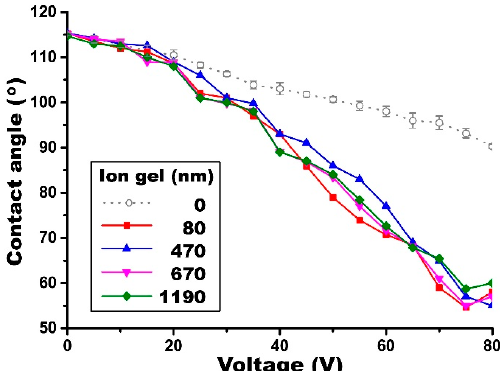
Figure 8. Thickness effect of the dip-coated gel layer on static EWOD performance. The gel layer thickness varies from 80 nm to 1.19 μ m, while the Teflon layer was fixed at 670 nm for all experiments. The droplet contact angles were measured at various input voltages. A negligible difference in EWOD performance was observed for the gel layers of varying thicknesses. For comparison, data from a bare Teflon layer of the same thickness is added to highlight the significant contribution of the dip-coated gel layer.